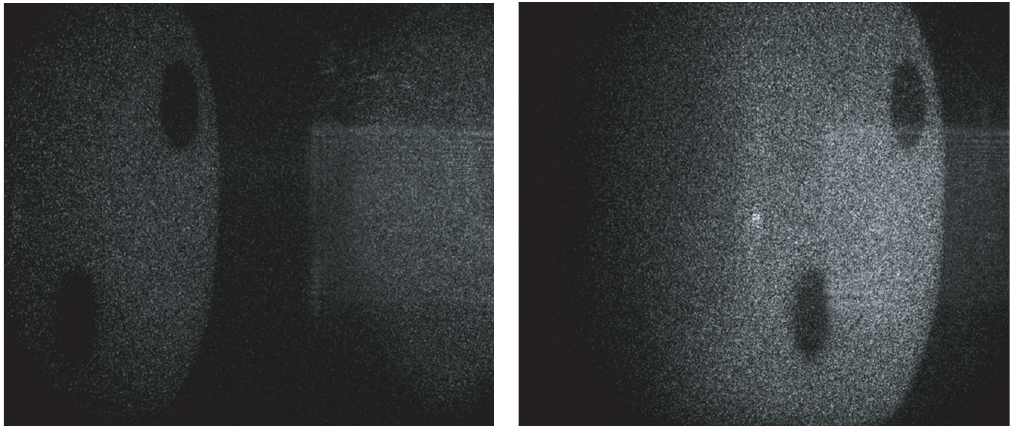
Figure 17: Reconstruction of synthetic aperture